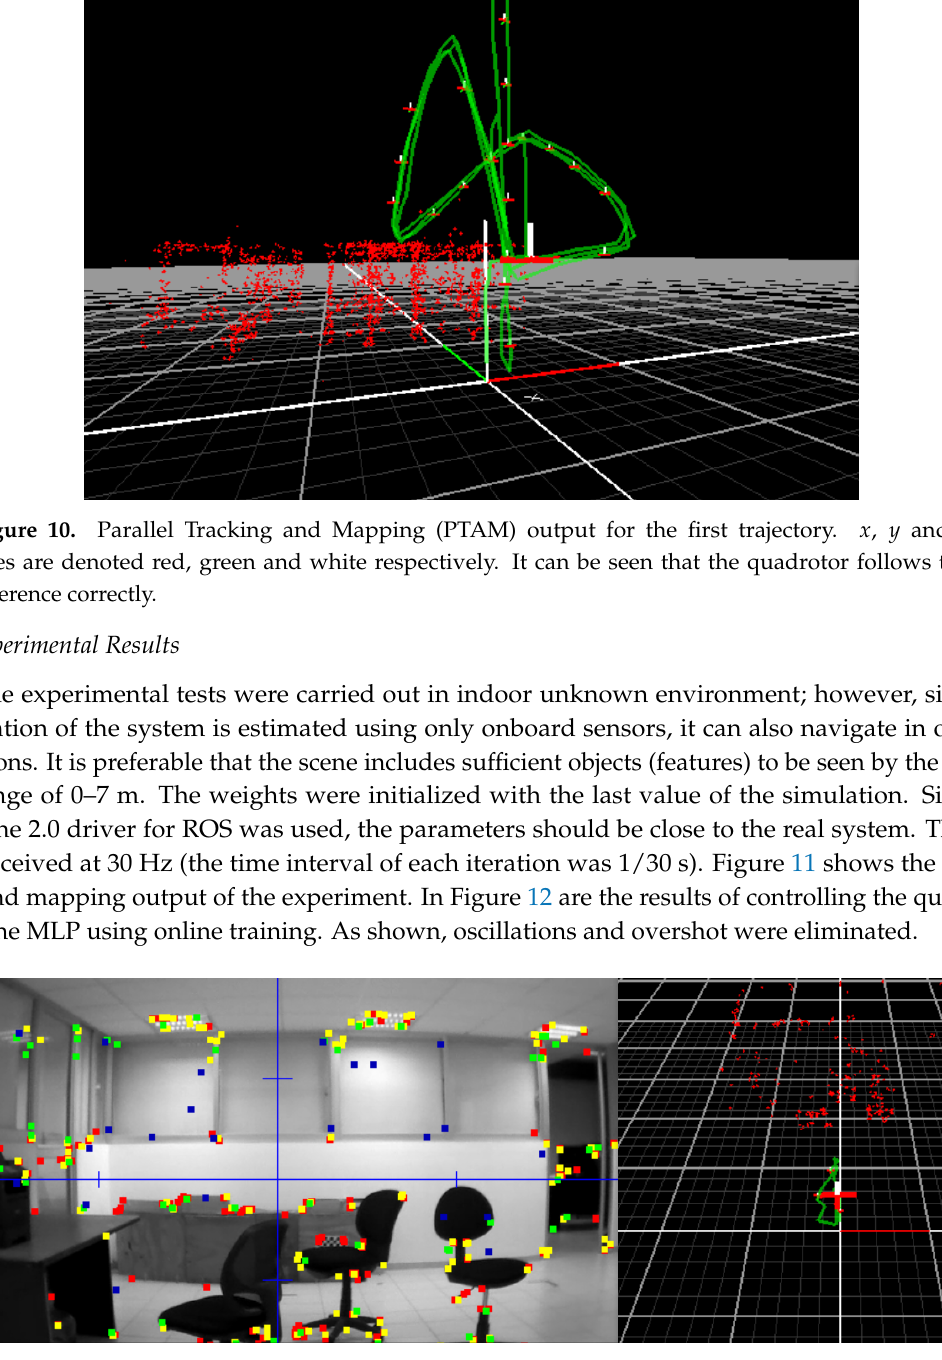
Figure 11. Camera view and map generated with PTAM for experimental